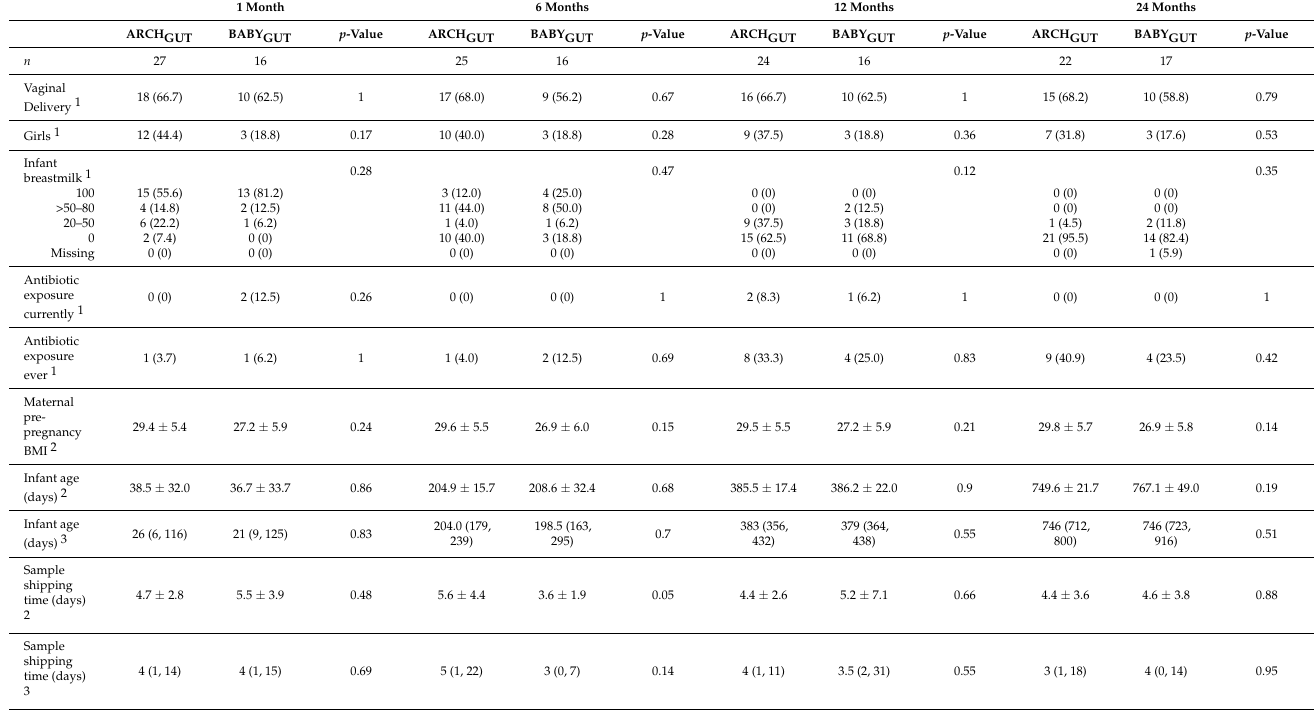
Table 1. Population characteristics of the infants at 1, 6, 12, and 24 months.